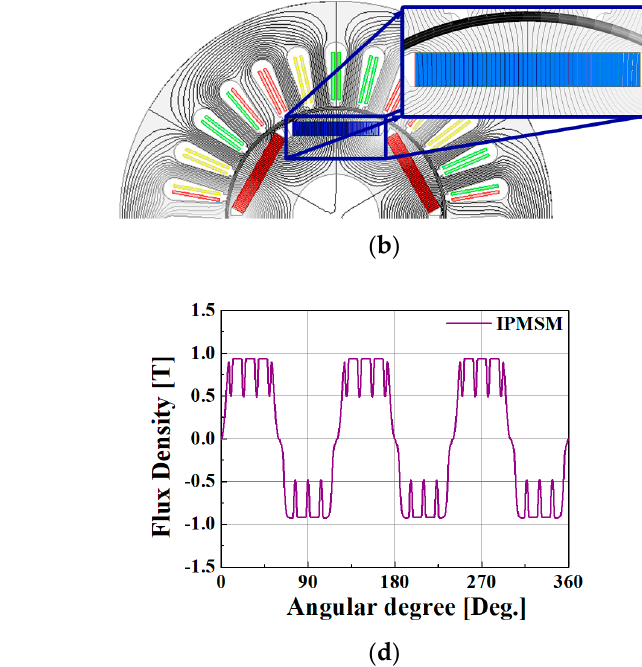
Figure 6. Results of characteristic analysis: ( a ) cogging torque; ( b ) torque ripple . loss analysis re- sults: ( c ) coreloss; ( d ) PM loss .